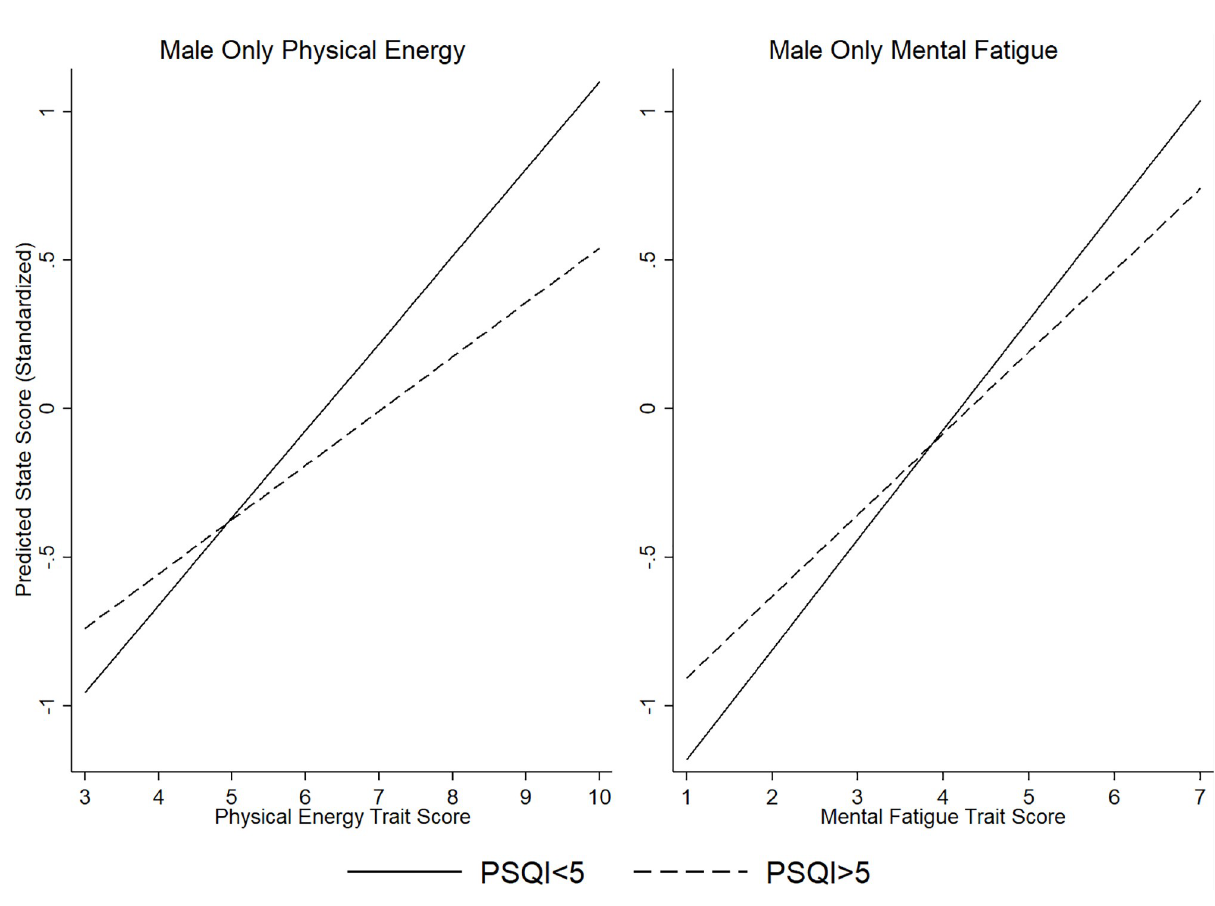
Fig 2. Interactions between sleep and trait in male only